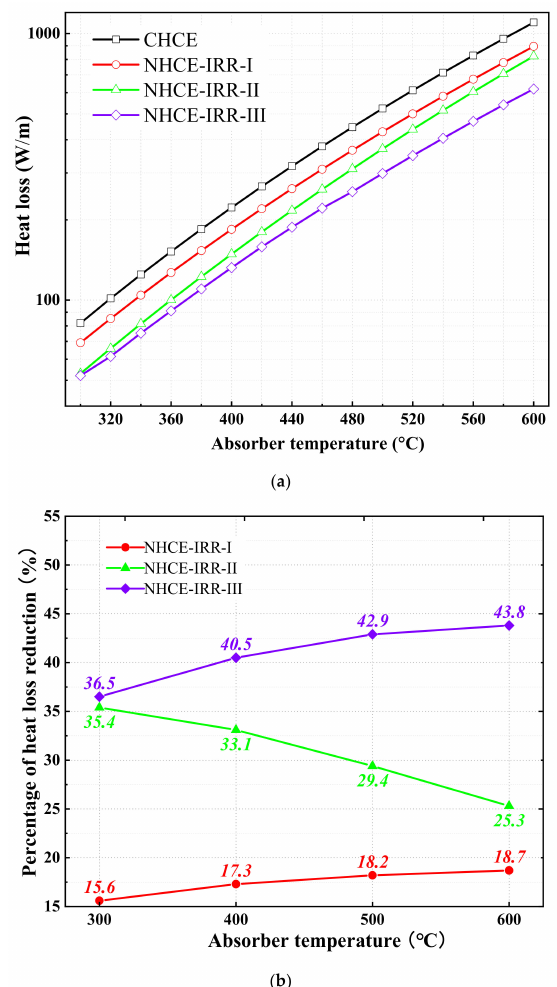
Figure 6. ( a ) Heat loss of four HCEs, ( b ) Percentage of the reduced heat loss of novel heat collecting elements (NHCEs) compared with conventional heat collecting elements (CHCEs). The ambient temperature and wind speed are set as 25 ◦ C and 2.5 m · s − 1